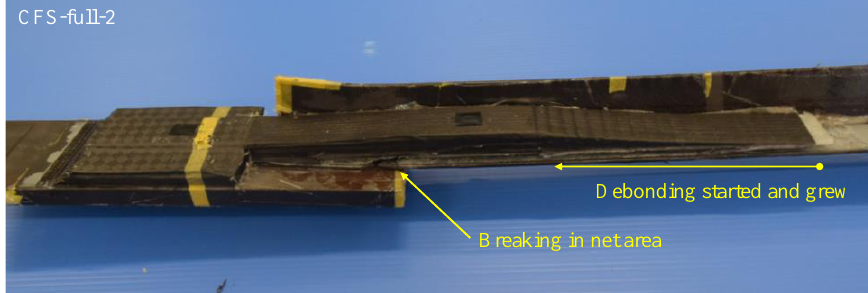
Figure 14. Load–strain (average of g2 and g3) relations: ( a ) a range of 0–4.5% strain; ( b ) a range of 0–1% strain.